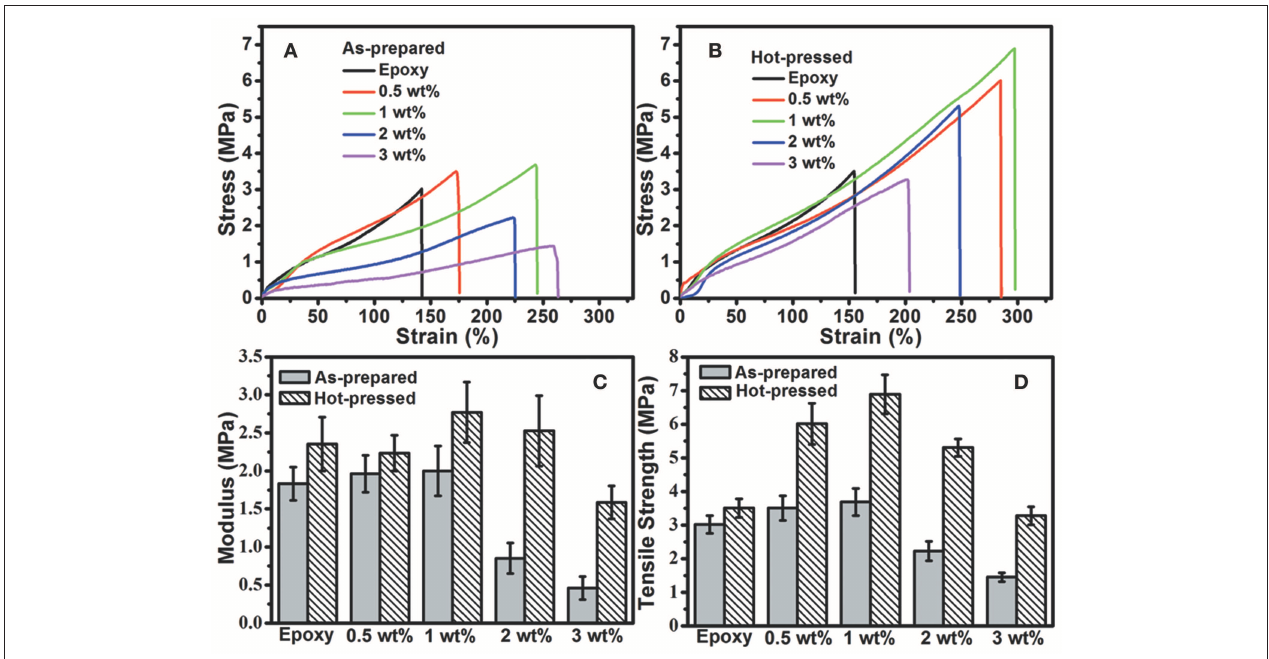
FIGURE 4 | Typical stress-strain curves of (A) aGnP/epoxy and (B) hGnP/epoxy composites. The comparisons of (C) modulus and (D) tensile strength of aGnP/epoxy and hGnP/epoxy composites with the same loading of GnP.